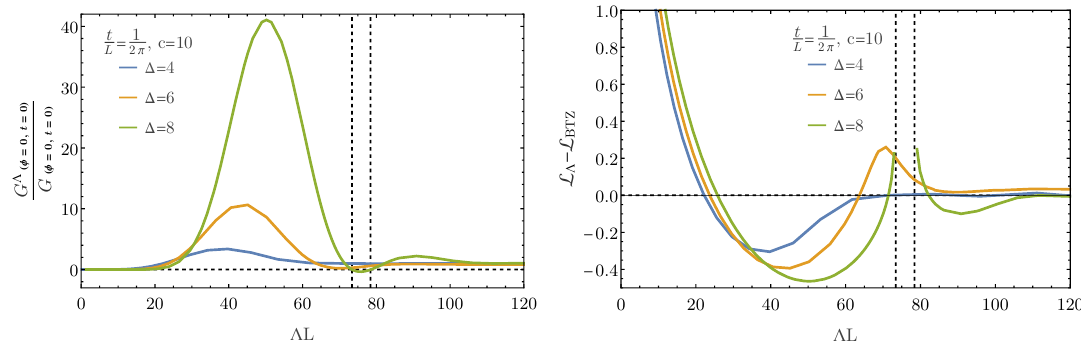
Figure 7 . Normalized Wightman function with (cid:12)nite cuto(cid:11) (left) and length di(cid:11)erence from BTZ (right) as de(cid:12)ned in eq. (4.7) for (cid:12)xed (cid:12)=L = 1 = 2. The central charge is c = 10 and spatial separation is zero. The vertical dashed lines indicate the region where the Wightman function is negative for